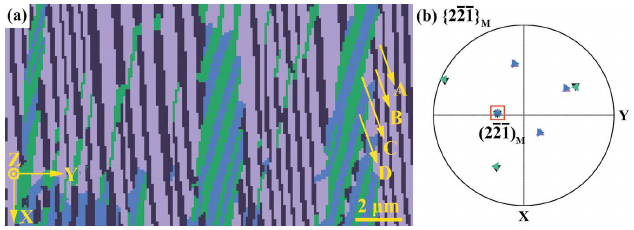
Figure 2 ( a ) Electron backscatter diffraction (EBSD) orientation micrograph of the sub-micrometric lamellar martensite variants in one plate. ( b ) A {2 21} M pole figure of the four variants. The common poles are included in the red square and the poles are presented with the same colours as in panel ( a